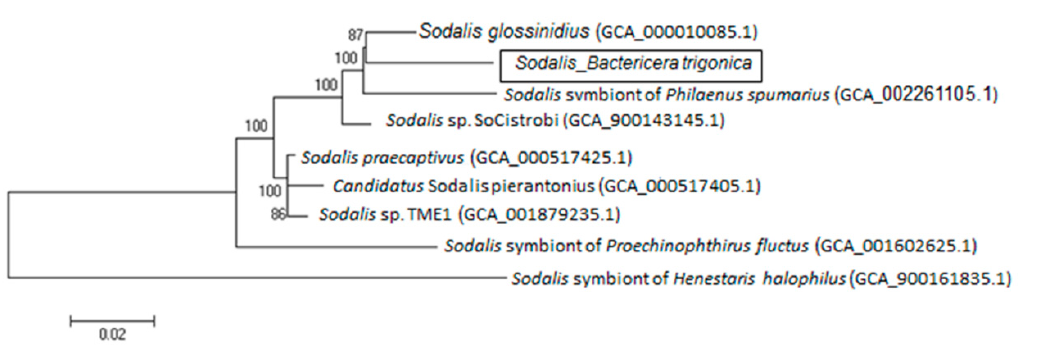
Figure 8. Phylogeny of 3404 orthologous genes (concatenated sequences of 347,000 bp each) of the Sodalis sp genomes available from the GenBank including the Sodalis identified from B. trigonica .